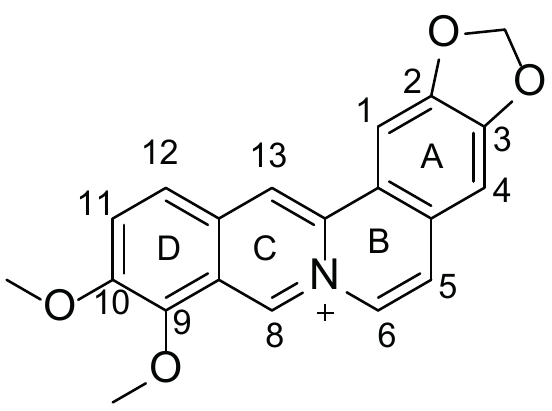
FIGURE 3 - The chemical structure of